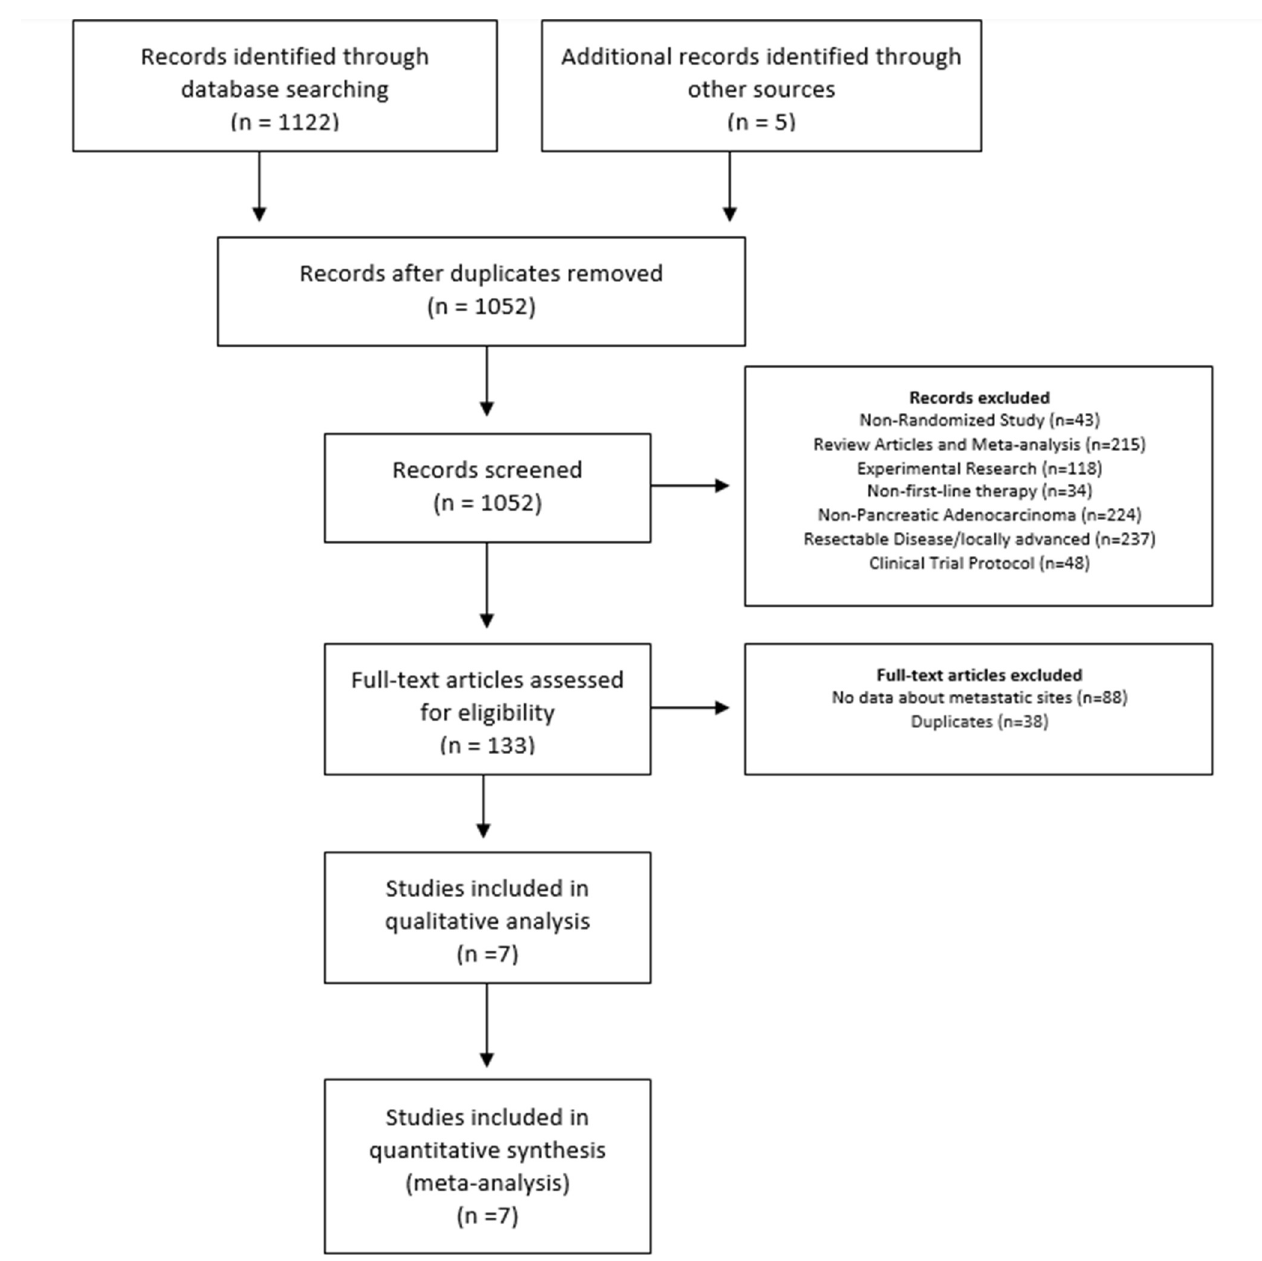
Fig 1. Flow Diagram of the included